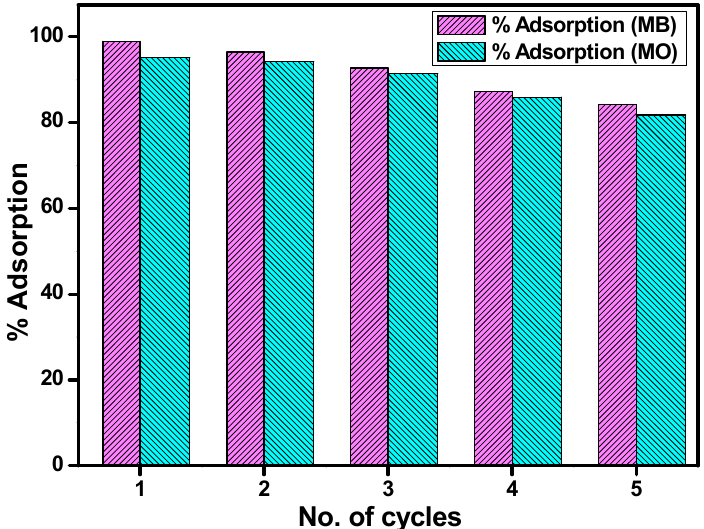
Figure 11. Reproducibility cycles of GOPSr-2 for MB and MO adsorption (initial MB and MO concentration: 20 mg · L − 1 ; amount of adsorbent (MB): 0.5 mg · mL − 1 , (MO): 2 mg · mL − 1 ; pH (MB): 9.5, (MO): 7; at room temperature).